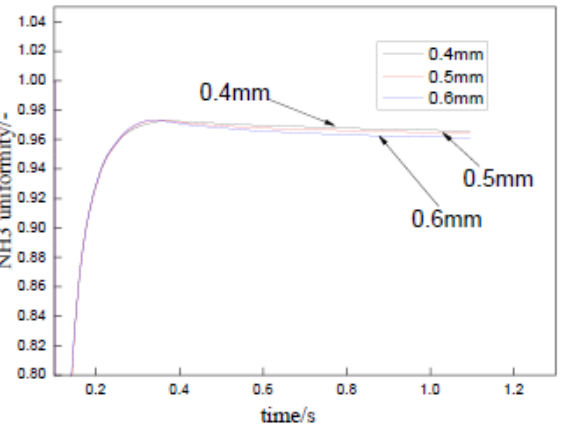
Fig. 14 Uniformity of NH 3 in inlet section of catalytic carrier under different nozzle